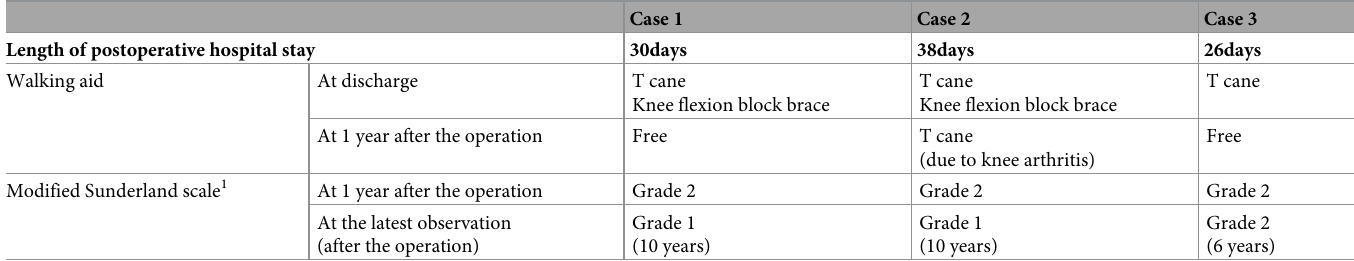
Table 2. Clinical course of each